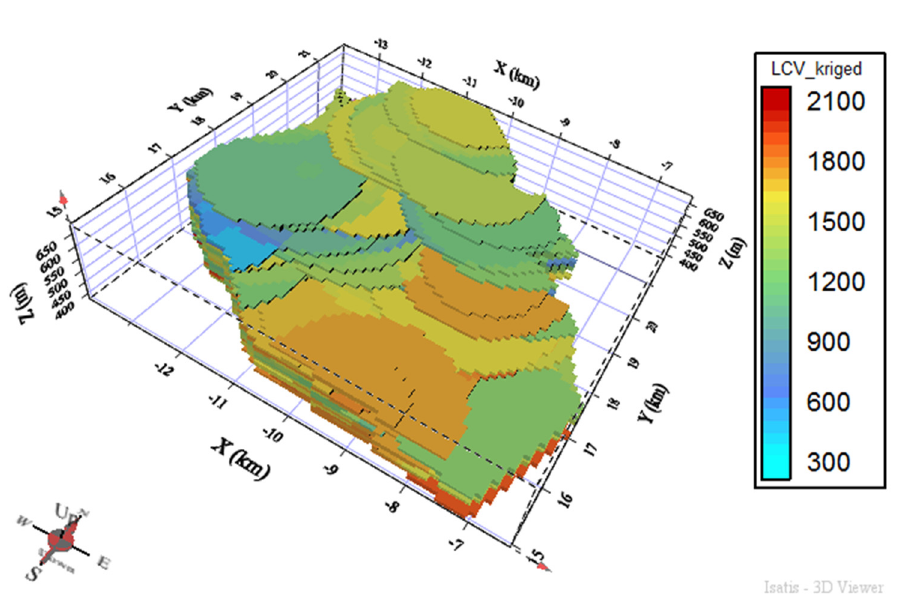
Figure 14. 3D model of LCV (kcal / kg) produced by application of kriging.